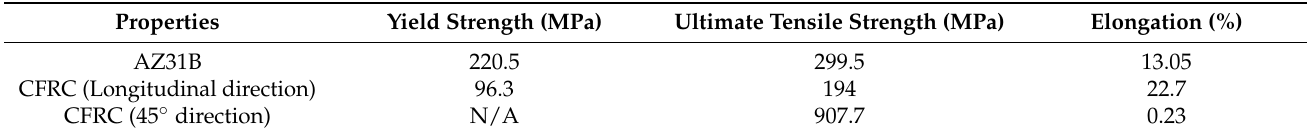
Table 2. Summary of mechanical properties for AZ31B and CFRC (for CFRC longitudinal, carbon fibers are aligned in 45 ◦ angle to the tensile direction, and for CFRC 45 ◦ , carbon fibers are parallel to the tensile direction). Properties